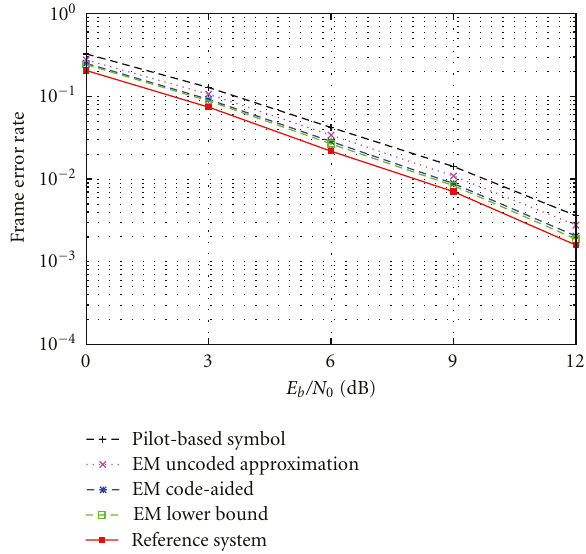
Figure 4: Frame Error Rate of the di ff erent proposed estimation techniques using 8-PSK mapping.